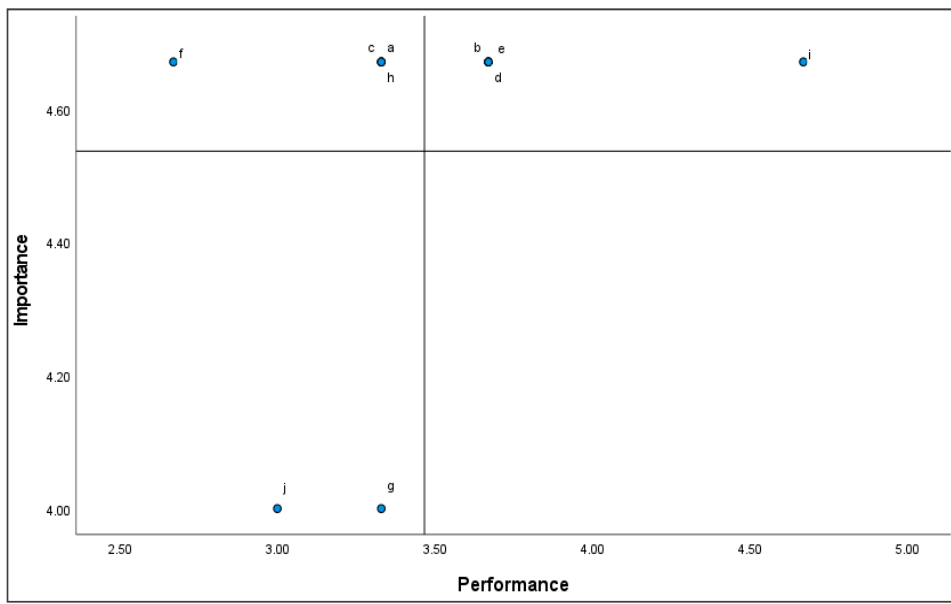
Figure 4. Importance-Performance Analysis (IPA) Graph for E-learning Strategies. 5. Discussion: IPA Recommendations by Quadrant, Kano Classifications, and Open